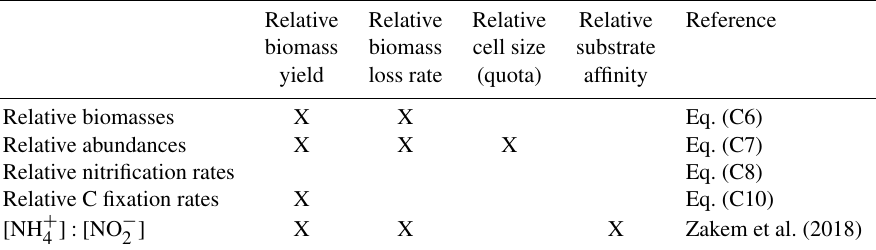
Table 2. Summary of the factors governing the relative abundances and water column rates of AOA and NOB in the dark, oxygenated ocean. The yield refers to the amount of biomass synthesized per amount of dissolved inorganic nitrogen utilized.